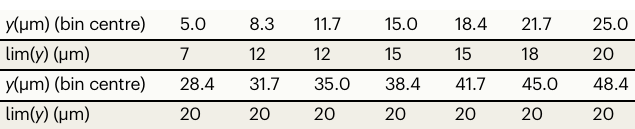
Table 2 | Limits in y for the y -dependent distributions of jumps J perpendicular to the channel